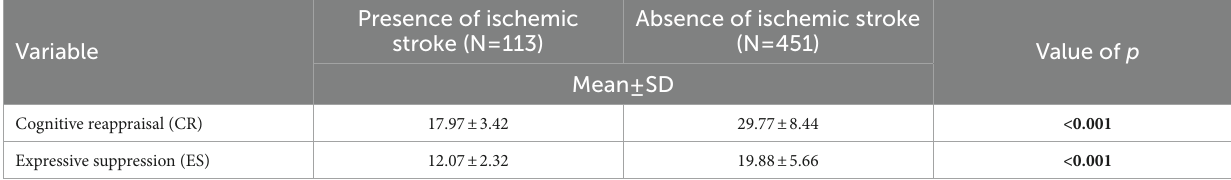
TABLE 2 Bivariate analysis of participants’ tendency to regulate their emotions and ischemic stroke.